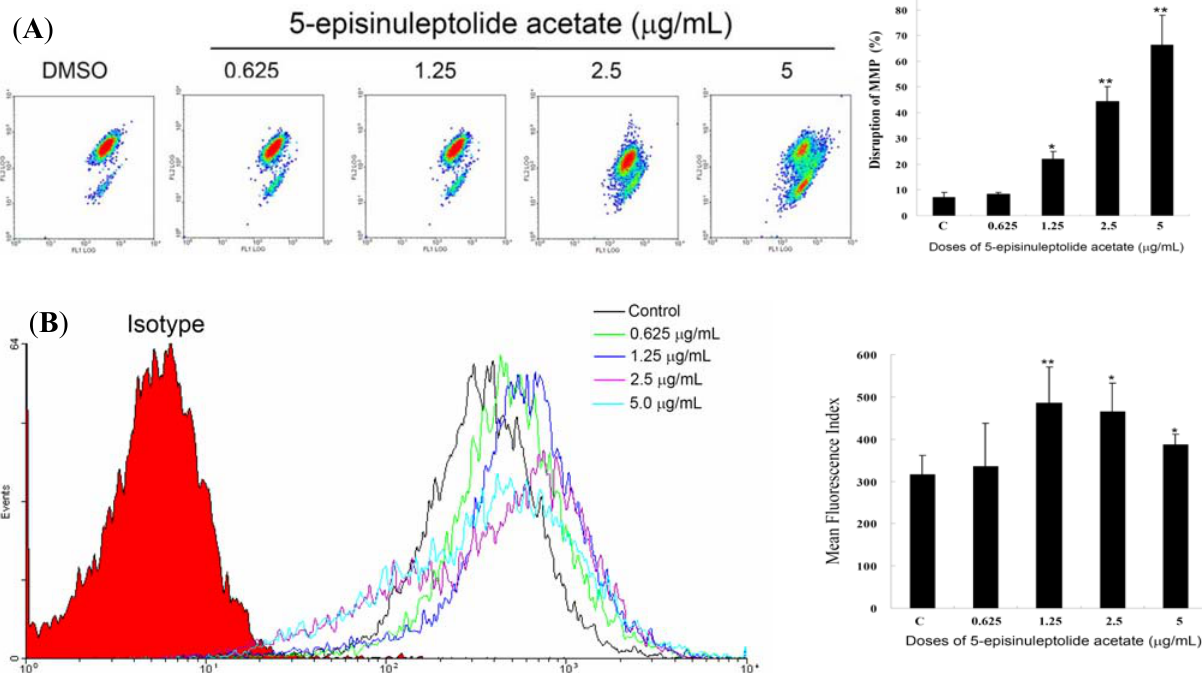
Figure 3. Flow cytometric results showing the effect of using different concentrations of 5EPA (0.625, 1.25, 2.5 and 5 μ g/mL) on the disruption of mitochondrial membrane potential (MMP), generation of ROS, and accumulation of calcium in HL 60